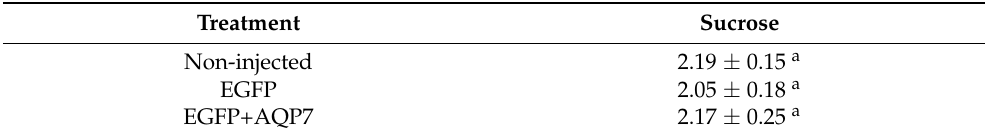
Table 3. Hydraulic conductivity ( L p ) of bovine oocytes injected with EGFP alone or EGFP + AQP7 cRNA exposed to HM medium containing 0.5 M sucrose at 25 ◦ C.